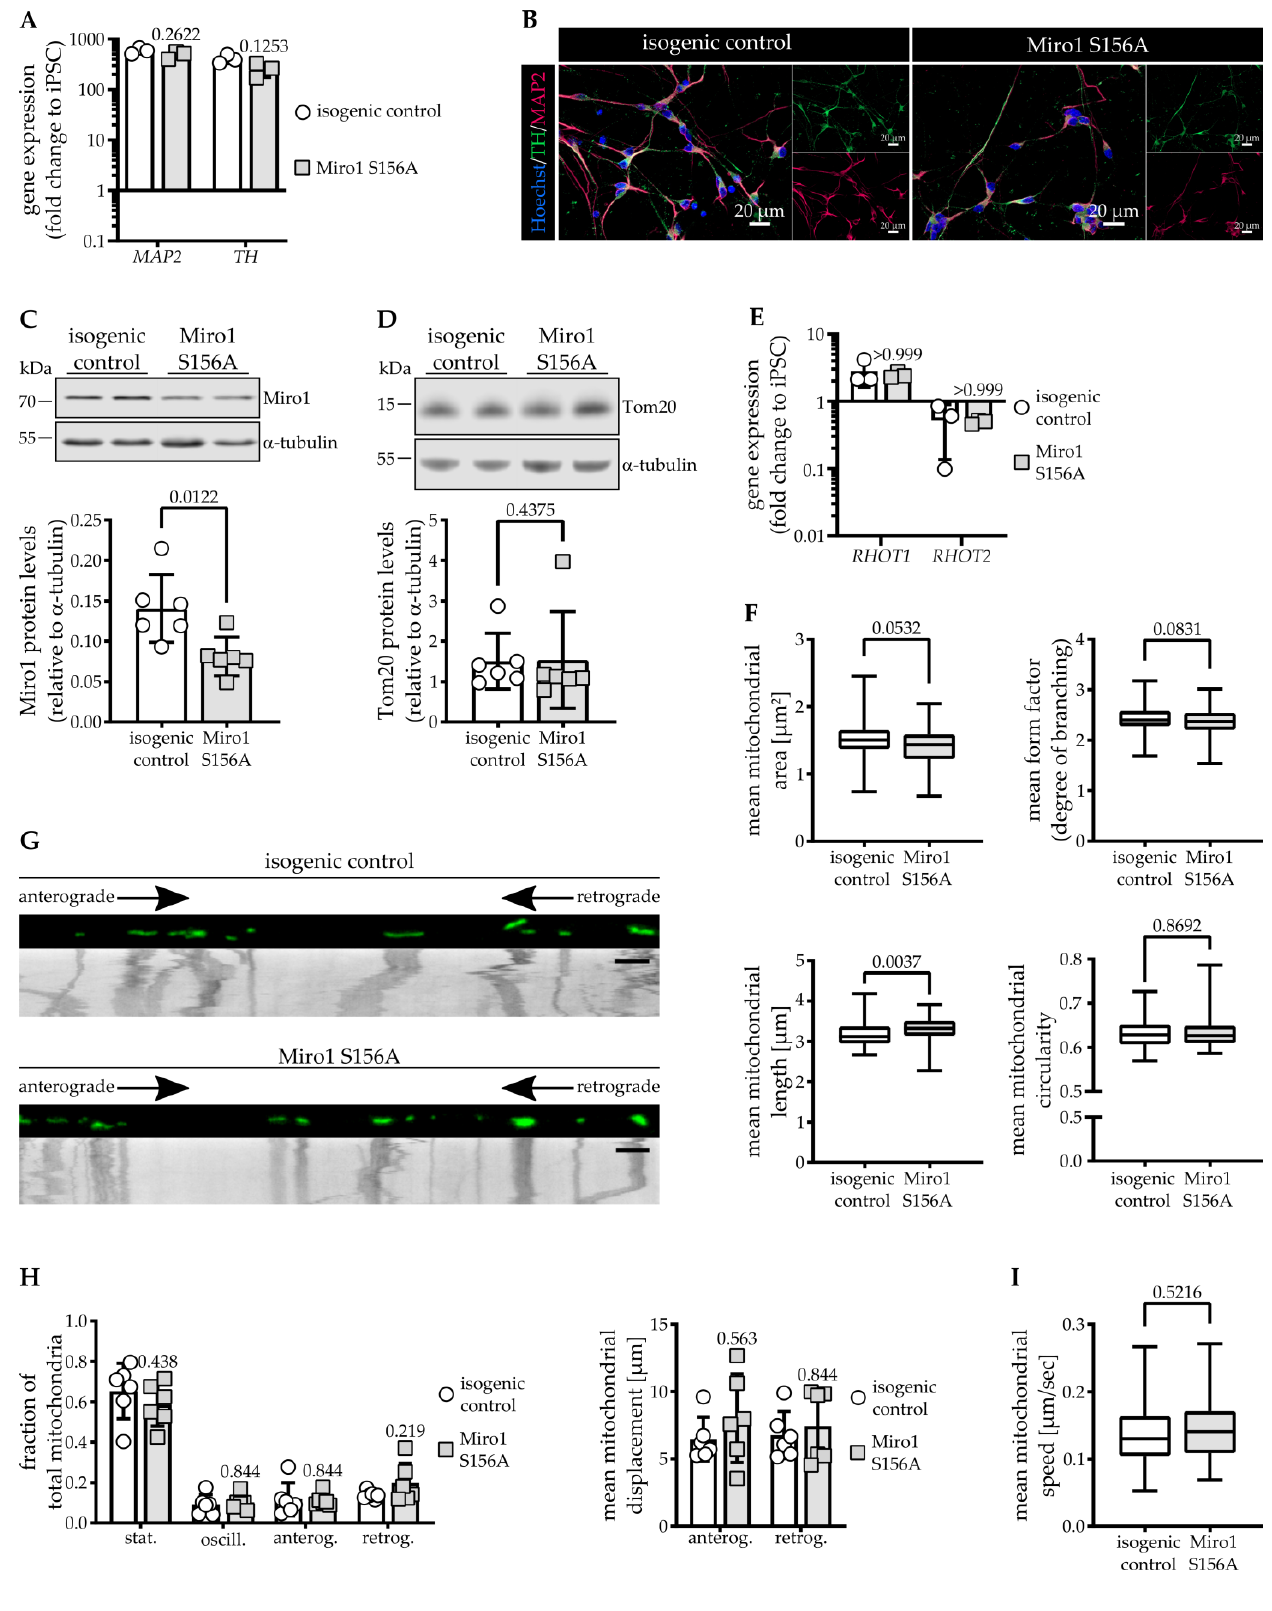
Figure 1. Reduction of Miro1 protein levels in Miro1 S156A hDaNs. ( A ) RT-qPCR showing expression of dopaminergic neuronal markers in hDaNs as fold change to iPSCs. Error bars depict SD (n Diff